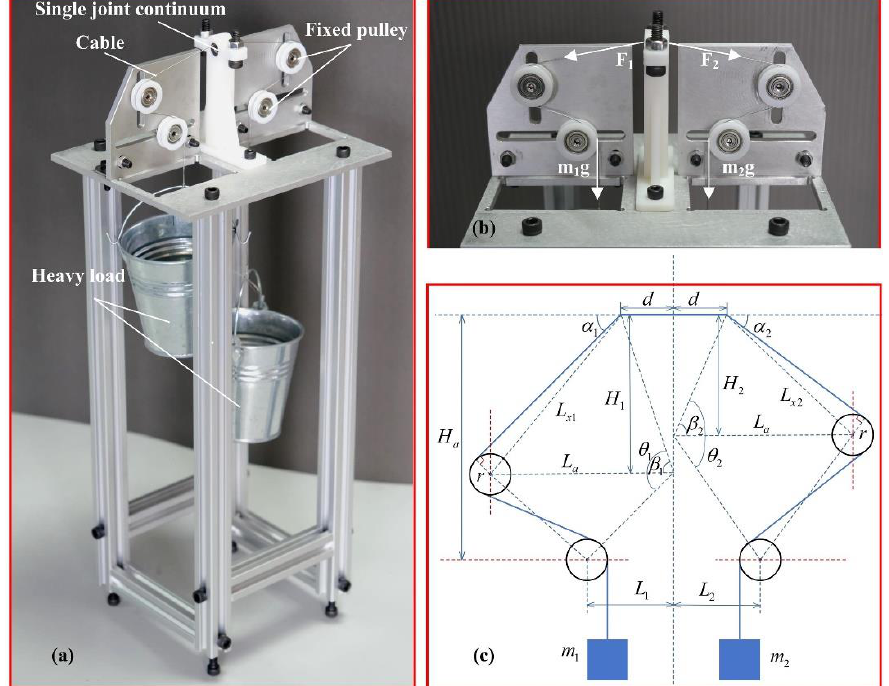
Figure 7. The experiment of determination of friction coefficient: ( a ) Experimental platform; ( b ) Enlarged view of experimental platform; ( c ) Experimental schematic diagram.